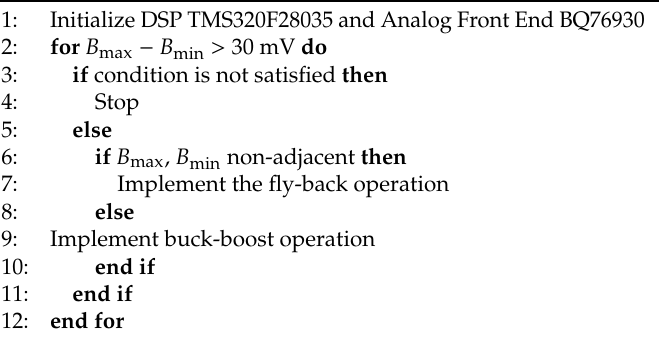
Table 3. Control procedure of the equalizer.